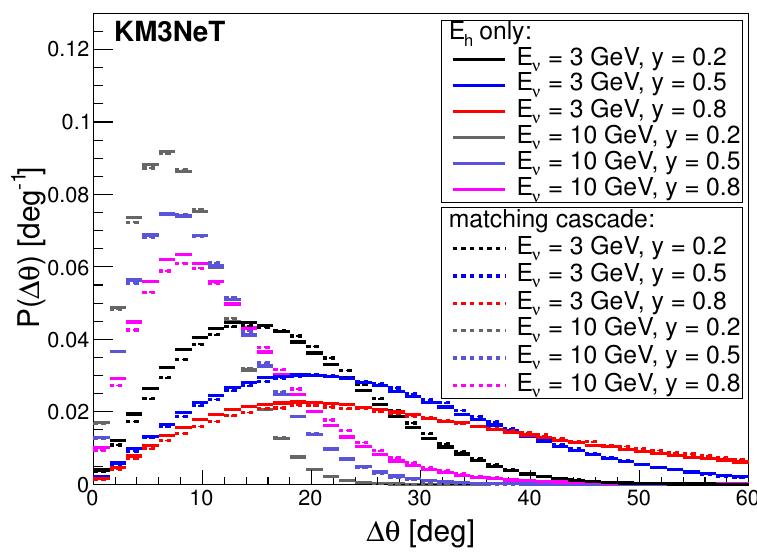
Figure 20 . Comparison of neutrino direction resolution (cid:1) (cid:18) calculated using the methods described in section 2.2, when selecting hadronic cascade using E h only; and when simulating the particular hadronic (cid:12)nal state matching each neutrino